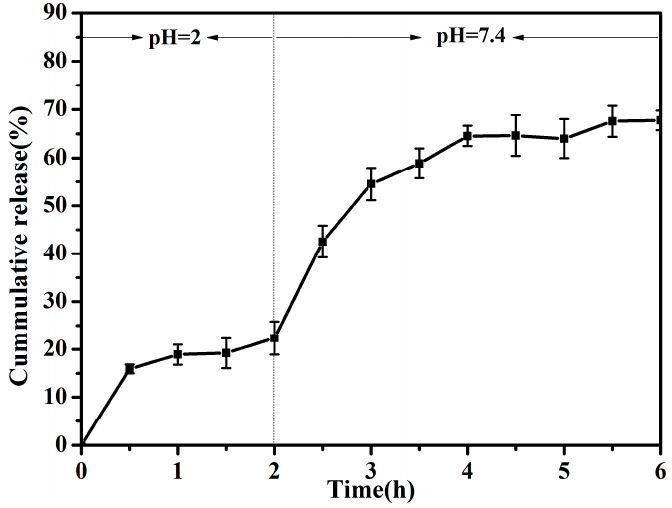
Figure 6. The release profile of PHLC-Ca in vitro in the gastrointestinal environments.